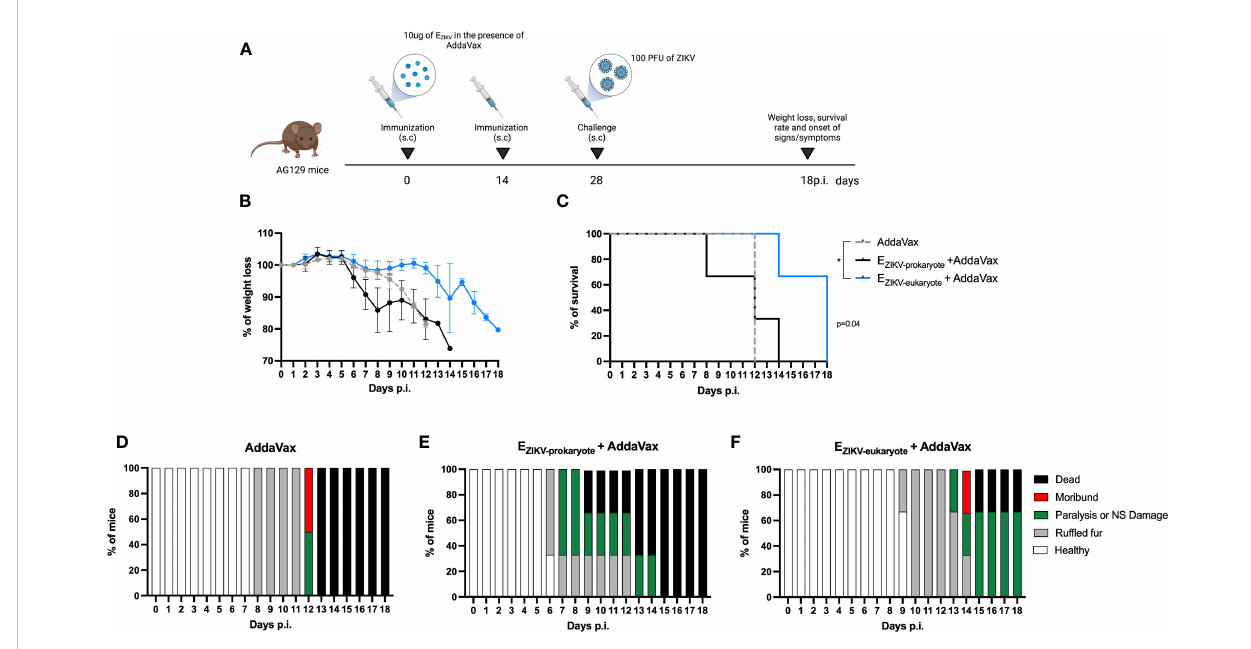
FIGURE 3 Protection of AG129 mice after immunization with E ZIKV protein expressed in S2 cells. (A) Immunization and challenge strategy (created with Biorender.com). AG129 mice (n=2 control groups and n=3 experimental groups) were immunized with two doses of the recombinant protein E ZIKV (10 m g, expressed in bacteria or S2 cells) in the presence of AddaVax or adjuvant alone by the subcutaneous route. Fifteen days after the boost, the animals were challenged with 100 PFU of ZIKV into footpads. After challenge, the animals were followed for 15 days to verify (B) weight loss, (C) survival rate and (D – F) signs/symptoms.